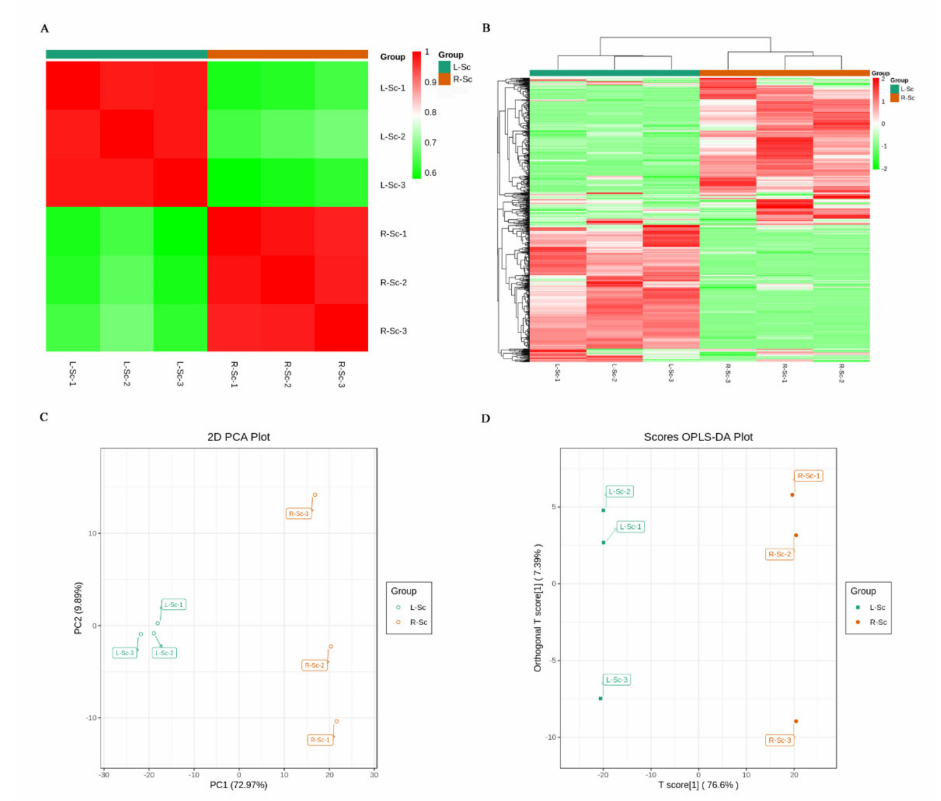
Figure 3. The identified metabolites analysis. ( A ) Pearson’s correlation coefficients among the L-Sc and R-Sc samples. ( B ) Cluster analysis of the identified metabolites from the L-Sc and the R-Sc. ( C ) Principal component analysis (PCA) of the L-Sc and R-Sc. ( D ) Orthogonal partial least squares discriminant analysis (OPLS-DA) model plot of the identified metabolites in the L-Sc and the